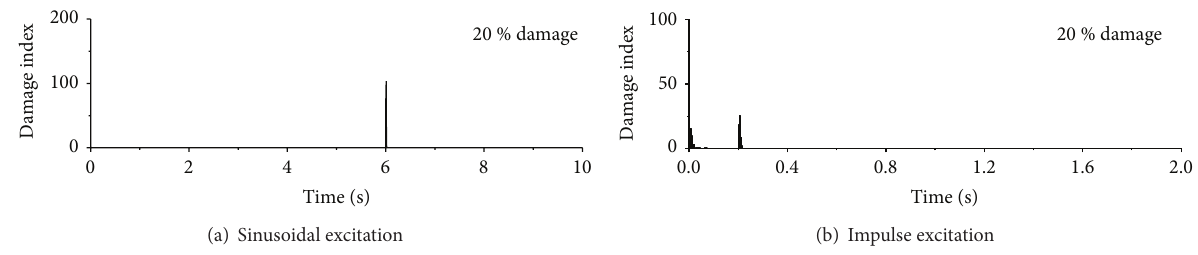
Figure 9: Damage detection using different db wavelets under seismic excitation.